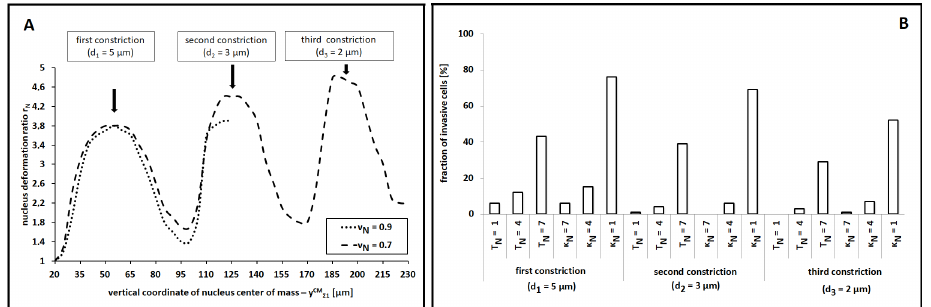
Figure 8. Quantification of cell migratory behavior in the case of the experimental setup used in [18]. ( A ) Time evolution of the deformation ratio of the nucleus, r N , defined in Equation (12), for two different values of its elasticity ν N . Each value is given as the mean over 10 simulations. We have not plotted error bars, to avoid unnecessary graphical overcomplication. However, standard deviations were very small (of the order of 10 − 2 ). ( B ) Percentage of cells that were able to overcome each constriction upon independent variations either in the nuclear motility T N or in the nuclear compressibility κ N (in the case of ν N = 0.9). As usual, values were calculated over 100 numerical realizations. We again remark that the initial diameter of the cell nucleus was d N = 16 µ